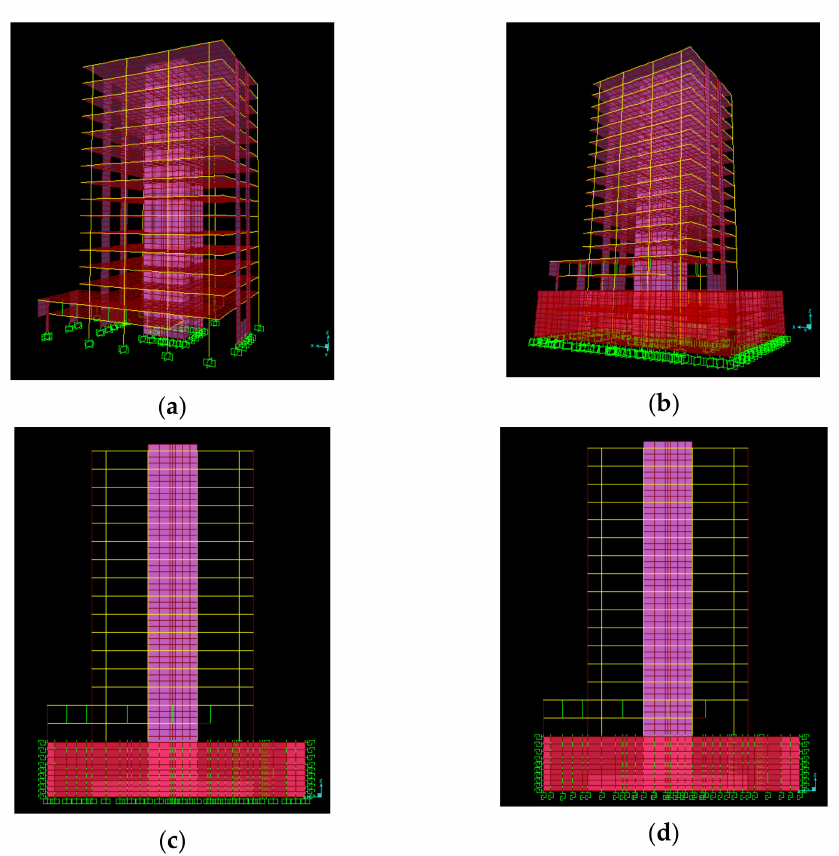
Figure 2. Model of the building: ( a ) embedded at the base of the first story; ( b ) embedded at the lowest underground level and without lateral ballast; ( c ) embedded at the lowest underground level with horizontal ballast; ( d ) using horizontal and vertical ballast in the soil-structure